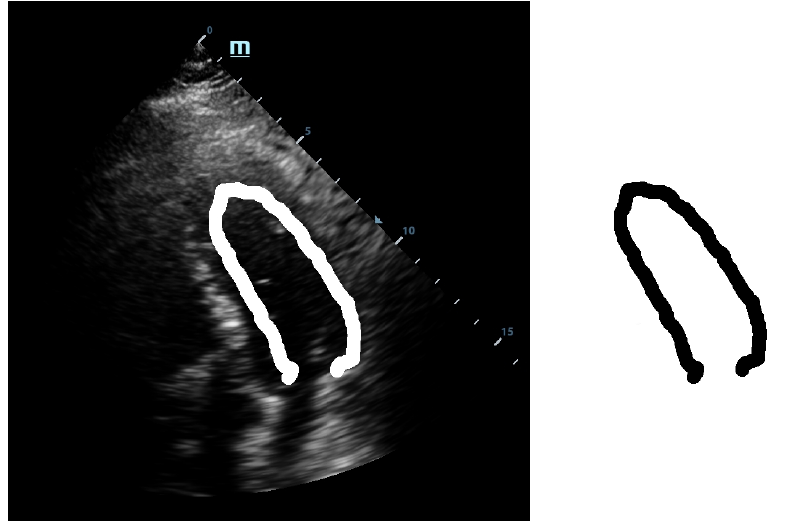
Figure 1. Initial drawing and template extraction.